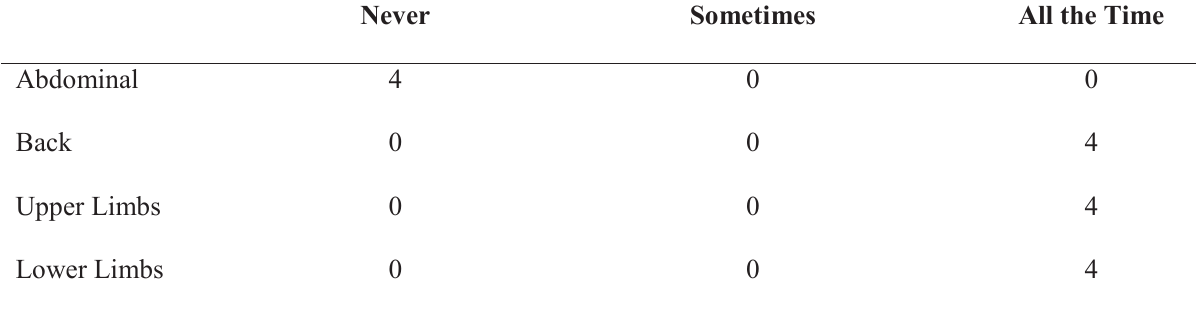
Questionnaire.Discomfort was prominent during procedures that lasted more than 27 minutes.